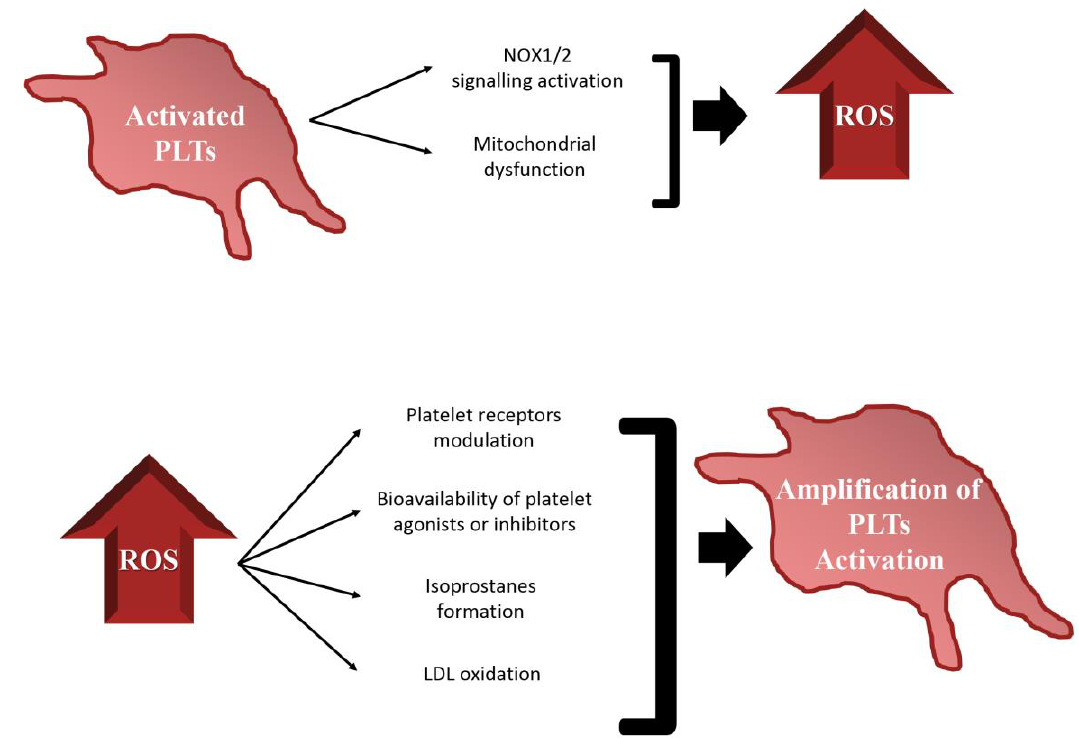
Figure 1. Schematic representation of the relationships between platelet functions and redox state. Activated platelets produce ROS, via NOX1 / 2 signaling activation and induction of mitochondrial dysfunctions. Intra- or extra-platelet ROS boost platelet activation by regulation of: platelet receptors function, bioavailability of platelet agonist or inhibitors, isoprostanes formation and low-density lipoproteins (LDLs) oxidation.